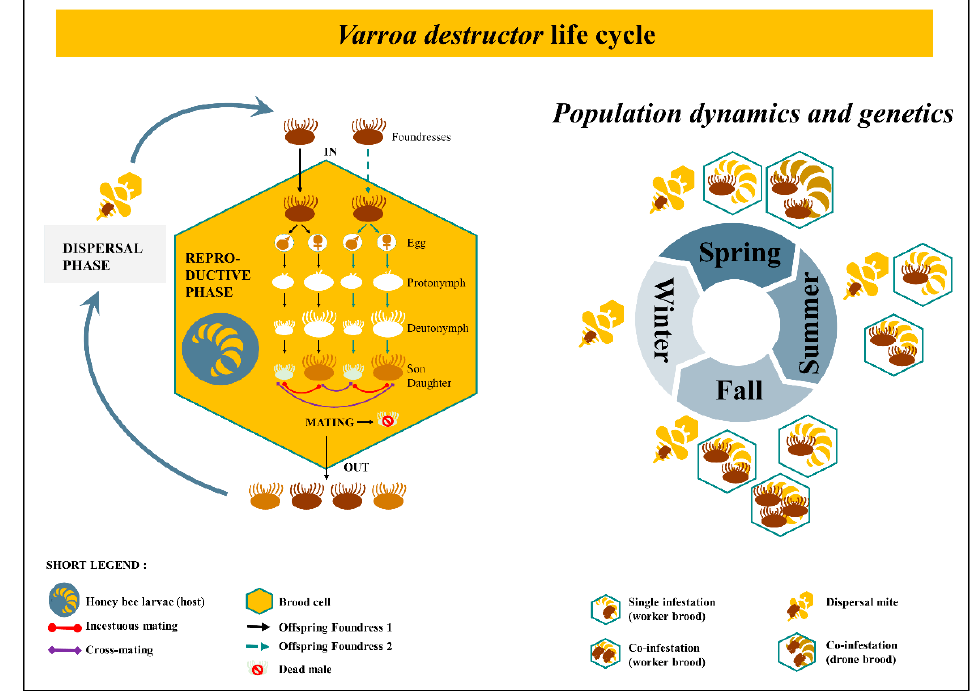
Figure 1. Varroa destructor life cycle and its population dynamics throughout the year. On the left, the two phases of the ecto-parasite cycle. The black line is in case of single infestation, the dashed line is in addition of the black one, thus in case of co-infestation in a brood cell. Inside the brood cell, the foundress laid eggs which go through several steps from protonymph to deutonymph until becoming a new daughter and son. On the right, the pattern of infestation over time. The balance between the number of brood available and the number of ecto-parasites in the colony influence the genetic diversity. Varroa destructor mating biology leads to intense inbreeding with no exchange among lineages in the population while a single foundress invades a brood cell in spring. Co-infestation happens in drone brood cell early in the year. However, cross-mating events occur around summer and fall with two or more foundresses co-infesting the same cell resulting in more heterozygous loci [54]. Contrary to assumptions, the ecto-parasite is genetically diversified with a dynamic structure over time